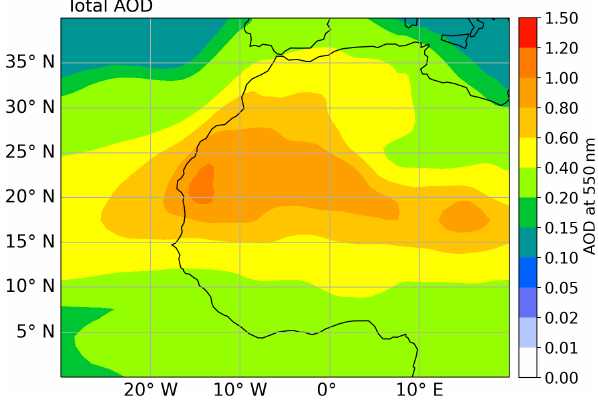
Figure 2. Total aerosol optical depth (AOD), from the NGAC fore- casts, averaged over 1–28 August